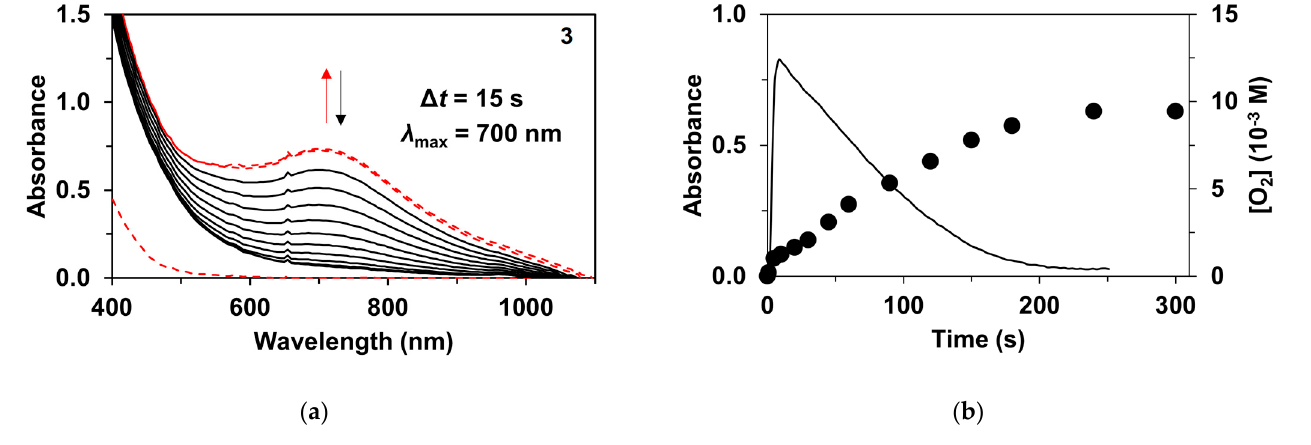
Figure 10. ( a ) UV–Vis spectral changes of 3 P during the catalytic disproportionation reaction of H 2 O 2 . ( b ) Time course of the formation and decay of 3 P during the catalytic disproportionation reaction of H 2 O 2 and the parallel formation of dioxygen monitored by UV–Vis spectroscopy at 700 nm and by volumetrically determined amounts of evolved dioxygen. [ 3 ] 0 = 1.0 × 10 − 3 M, [H 2 O 2 ] 0 = 0.3 M, T = 298 K in MeCN.